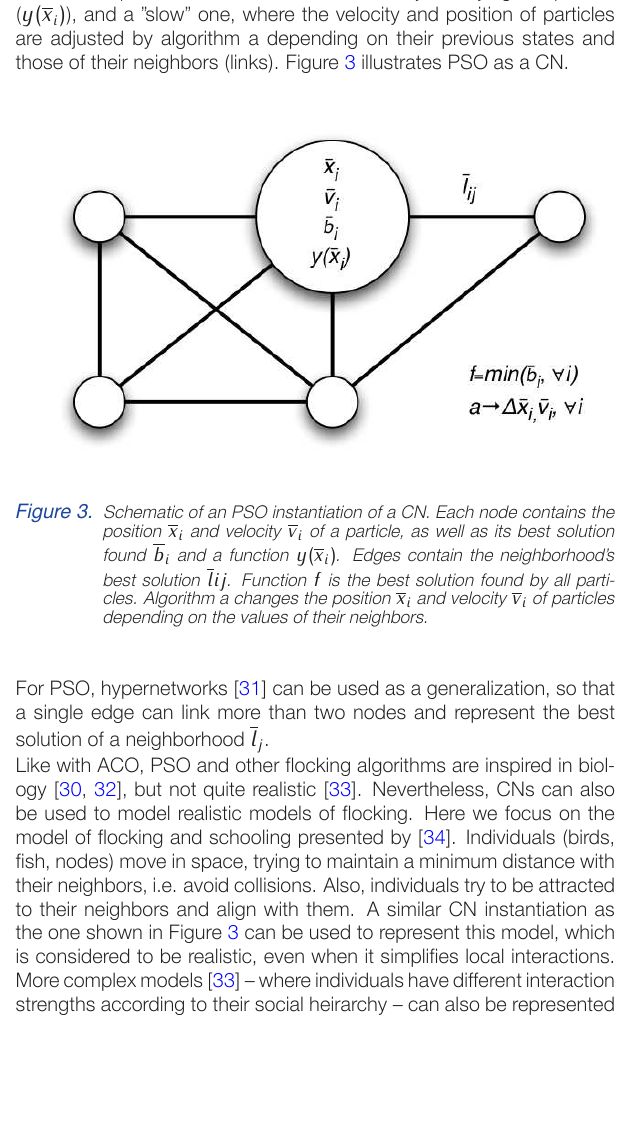
For PSO, hypernetworks [31] can be used as a generalization, so that a single edge can link more than two nodes and represent the best solution of a neighborhood l j